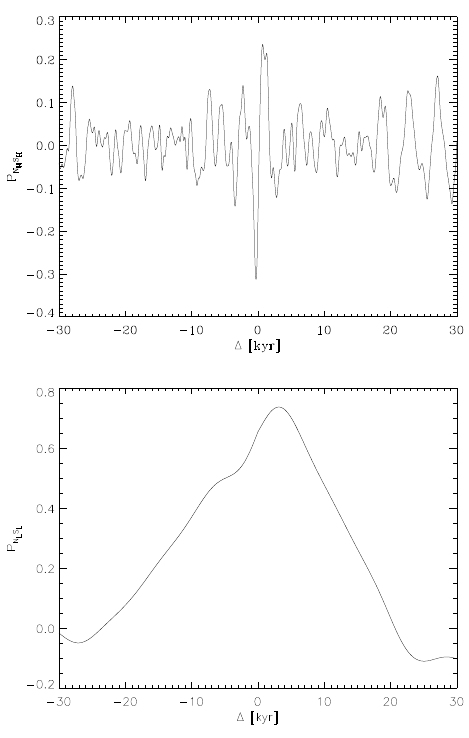
Figure 7. Cross-correlation coefficients between EDML and Fig. 7. Cross correlation coefficients between EDML and NGRIP (1) , top panel) and long timescale NGRIP short timescale ( P N H S H ((cid:1)) , top panel) and long time-scale short time-scale ( P N (1) , bottom panel) EMD reconstructions as functions of the ( P N H S H L S L ((cid:1)) , bottom panel) EMD reconstructions as functions of ( P N L S L time lag 1 the time lag (cid:1) .